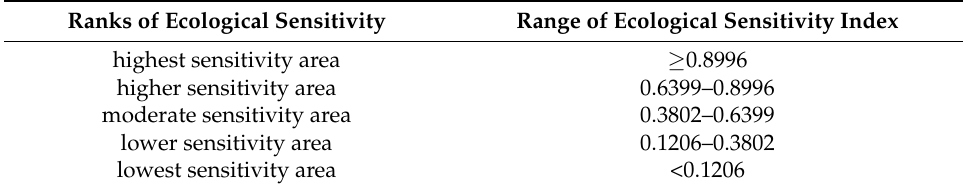
Table 2. Classification system of ecological sensitive areas in Zhengzhou.